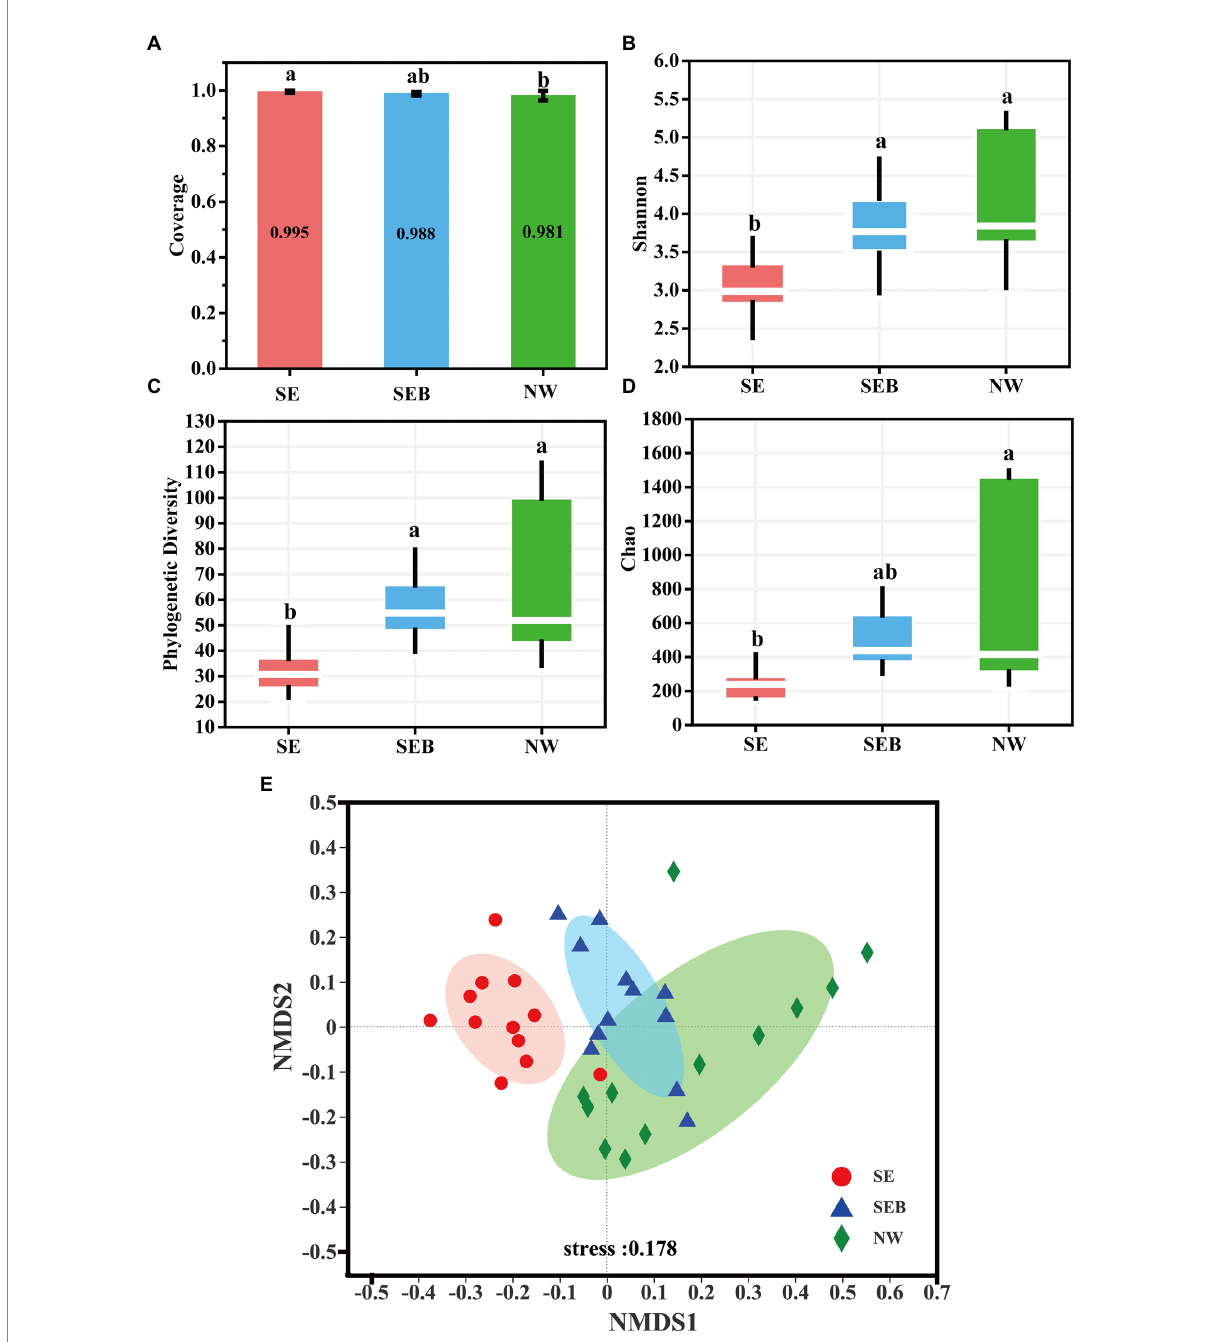
FIGURE 3 Alpha and beta diversity of B. calyciflorus -associated bacterial communities. (A) Coverage evenness index. (B) Shannon diversity index. (C) Phylogenetic index Pd. (D) Chao species richness. The bottom and top of the box represent the first and third quartiles, while the thick horizontal line represents the median. In the figure, the same lowercase letter indicates that the difference is not significant, while different letters indicate that the difference is significant (based on wilcoxon rank-sum test). (E) Non-metric multidimensional scale analysis (NMDS) based on bray-curtis distance. The inter-group difference test was based on ANOSIM. Points with different colors or shapes represent different groups of samples, and the closer the two sample points are, the more similar the species composition of the two samples is. Horizontal and vertical coordinates represent relative distance, which has no practical